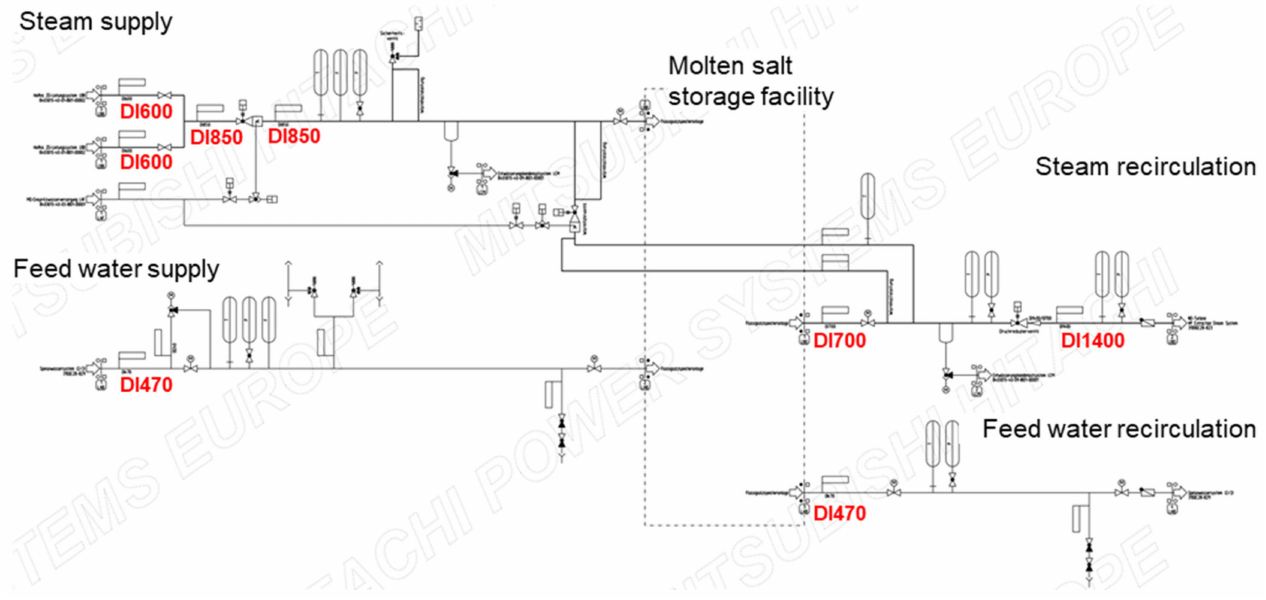
Figure 25. Process flow diagram connecting piping systems (concept